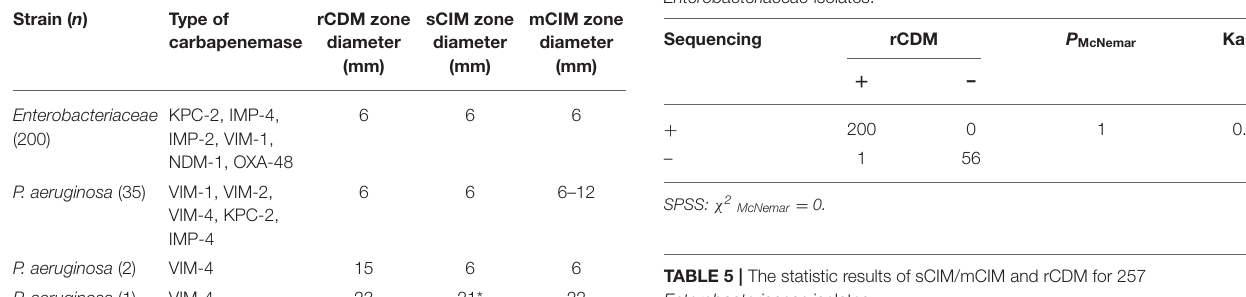
TABLE 4 | The statistic results of sequencing and rCDM for 257 Enterobacteriaceae isolates.